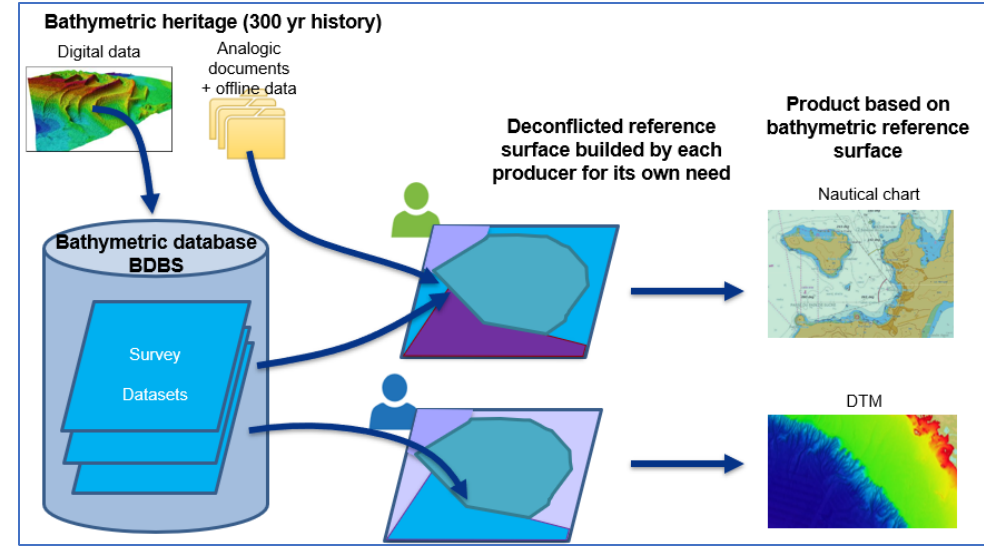
Figure 1. General operation before the Téthys project, where each operator recovers all the data before processing it according to his needs.